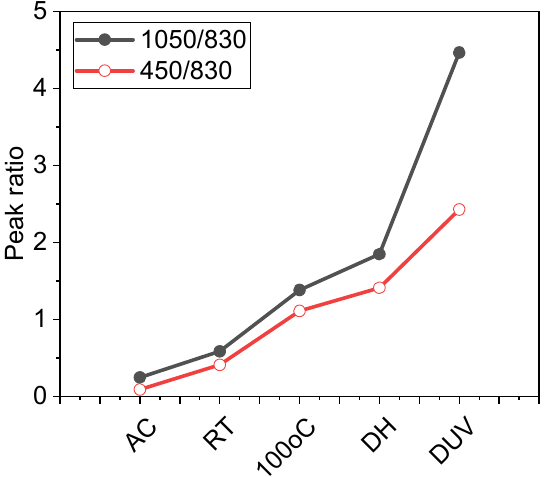
Figure 2. FTIR spectra of PHPS cured with different methods, Black curve with closed black circle represents peak ratio of I (1050 cm − 1 )/ I (830 cm − 1 ) for all methods and red curve with open circle represent peak ratio of I (450 cm − 1 )/ I (830 cm − 1 ) peaks for all methods. AC, RT, 100 °C, DH and DUV represents as coated, room temperature, heated at 100 °C, damp heat and deep UV, respectively.